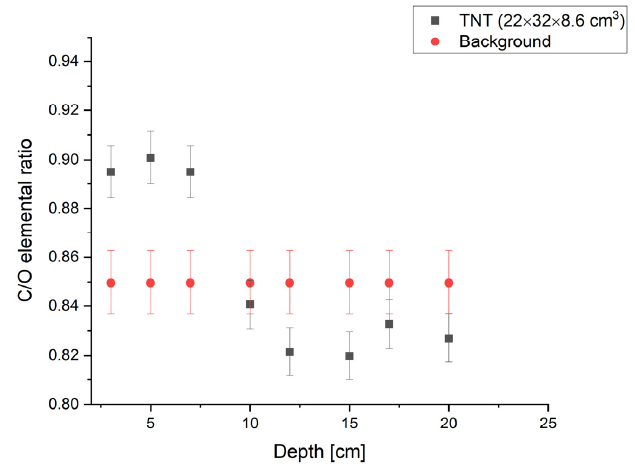
Figure 7. C/O elemental ratio as a function of the depth at which the TNT sample was buried for the detector positioned 2 cm above the ground.